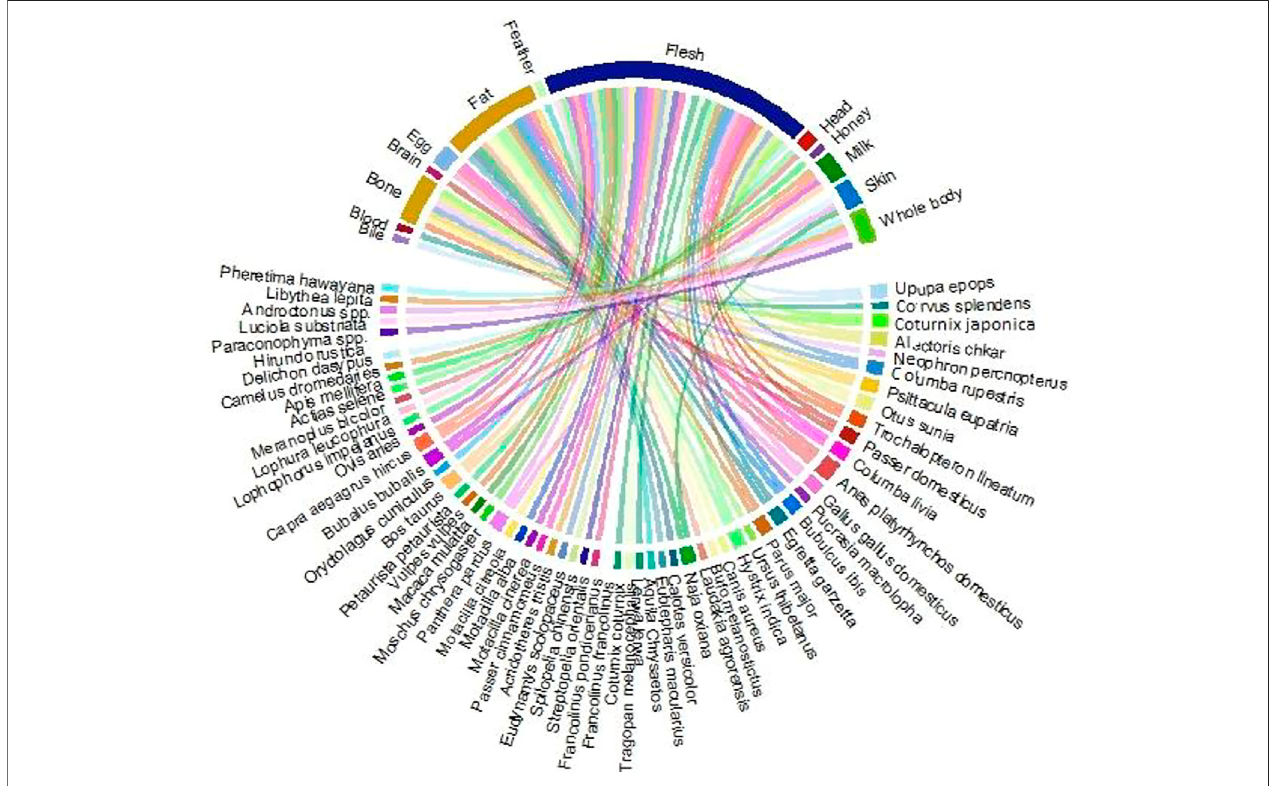
FIGURE 4 | Body parts of animal species used in different